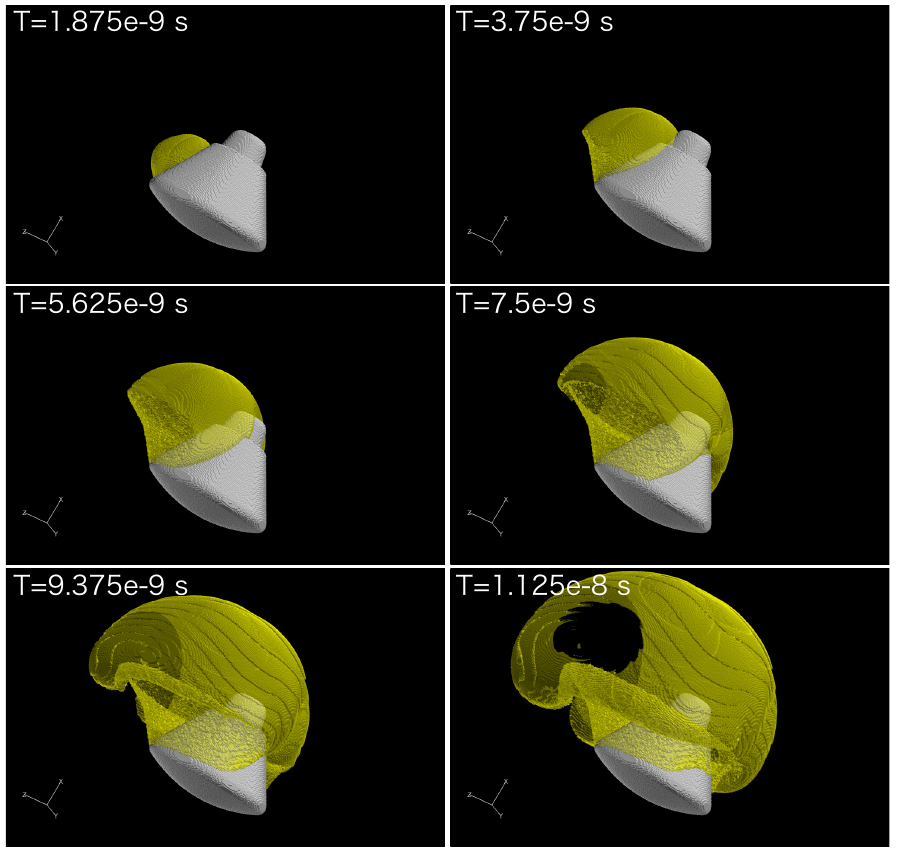
Figure 12. Time sequence of isosurfaces of the electric field around the ESA ARD at an altitude of 85